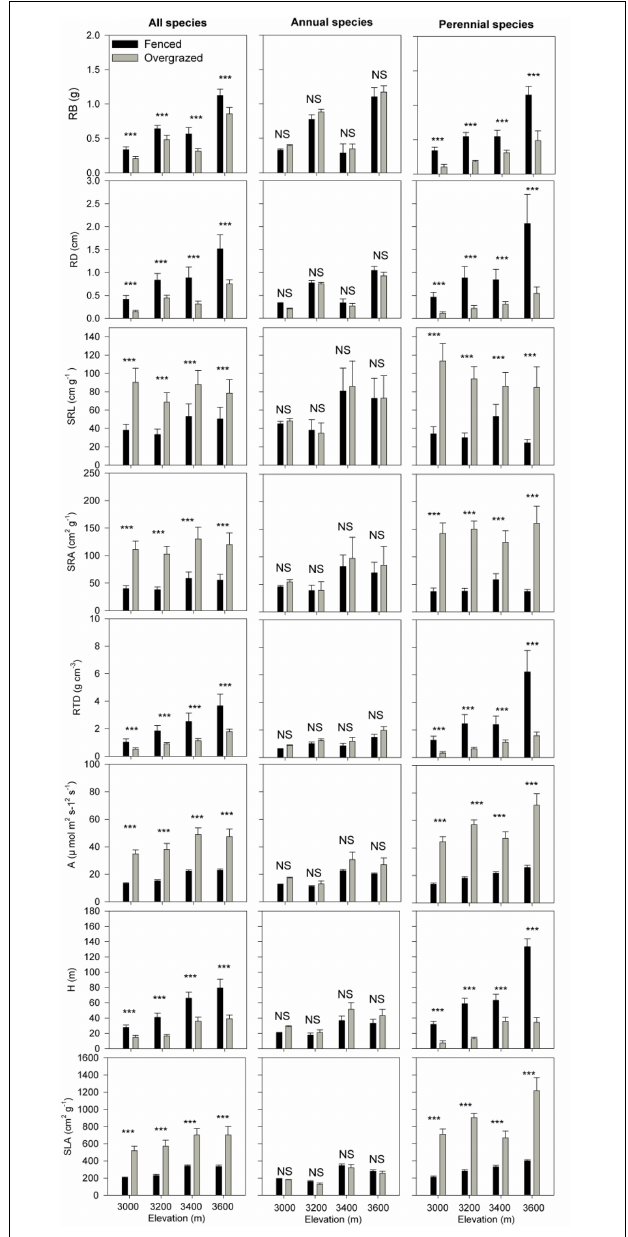
FIGURE 2 | The differences in above-ground traits [maximum height (H), leaf maximum photosynthesis rate (A) and specific leaf area (SLA)] and below-ground traits [root average diameter (RD), root biomass (RB), specific root length (SRL), specific root area (SRA) and root tissue density (RTD)] between fenced and overgrazed meadows for all species (left panel) and separately for annual (middle panel) and perennial (right panel) species from 3000 to 3600 m elevations. *** and NS (non-significant) indicates P < 0.001 and P > 0.05 based on Wilcoxon signed-rank